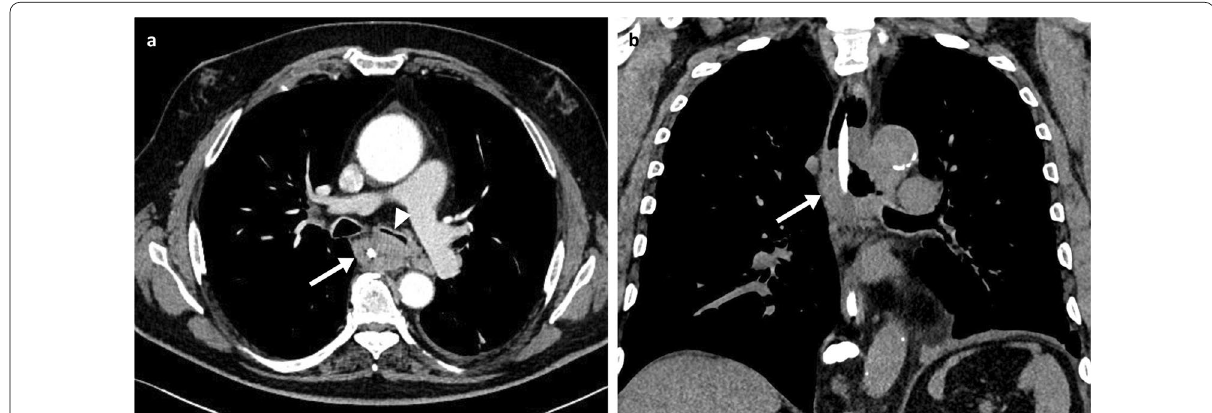
Fig. 2 Arterial phase contrast-enhanced CT axial ( a ) and non-enhanced coronal ( b ) of a 58-year-old male patient demonstrating a large oesophageal metastatic melanoma mass (arrows) with luminal narrowing and compression of the left main bronchus (arrowhead). A nasogastric tube is in